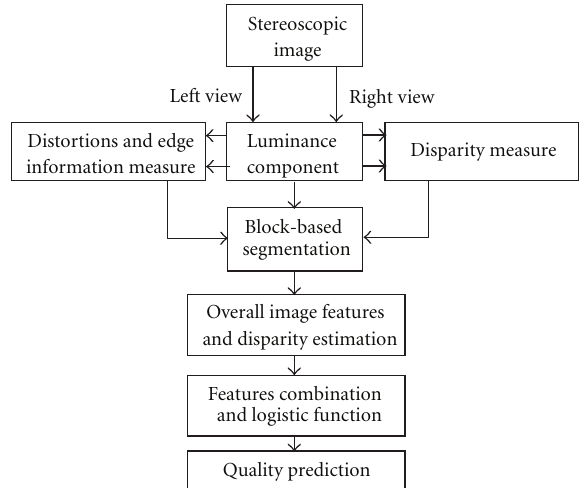
Figure 2: Proposed NR quality evaluation